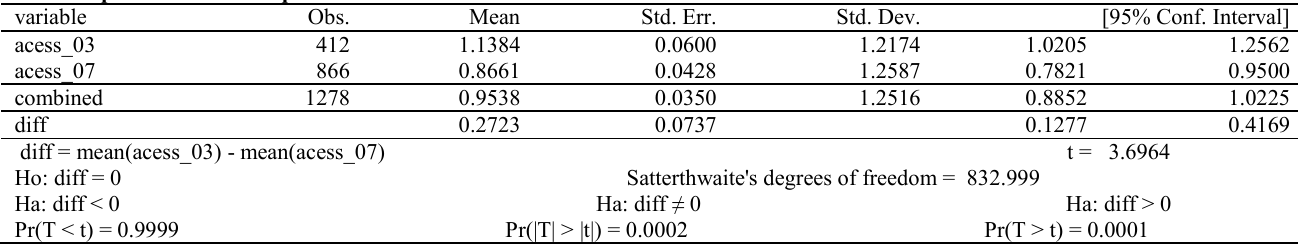
Table 8: Two-period review of the importance of access to finance importance Two sample t -test with Unequal variances of 2003 vs.